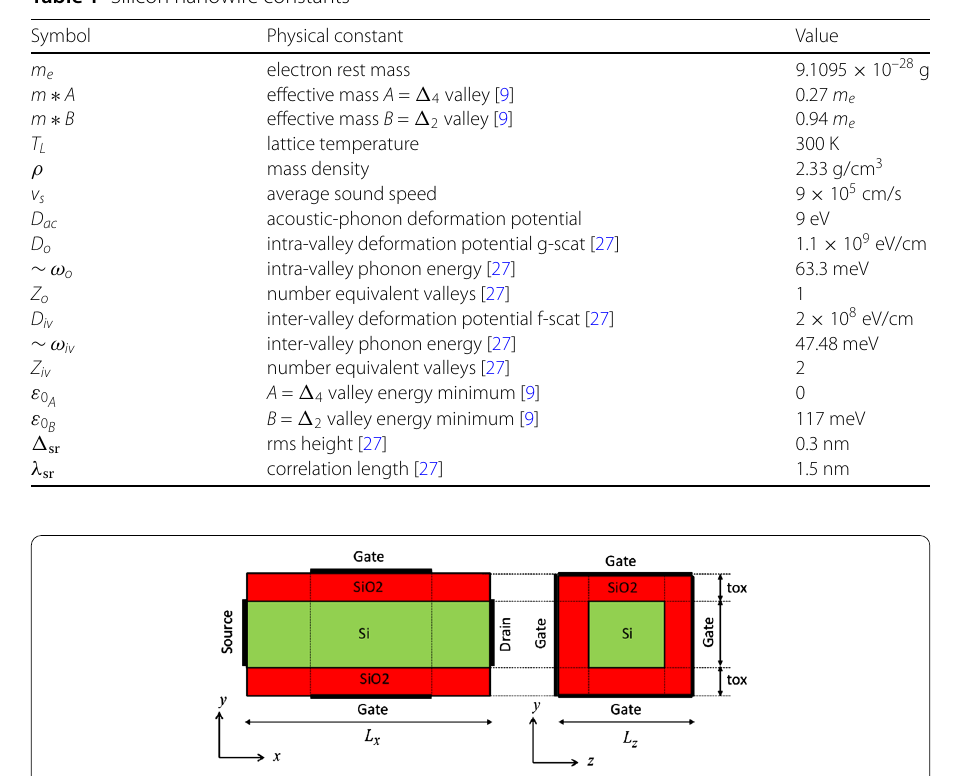
Table 1 Silicon nanowire constants